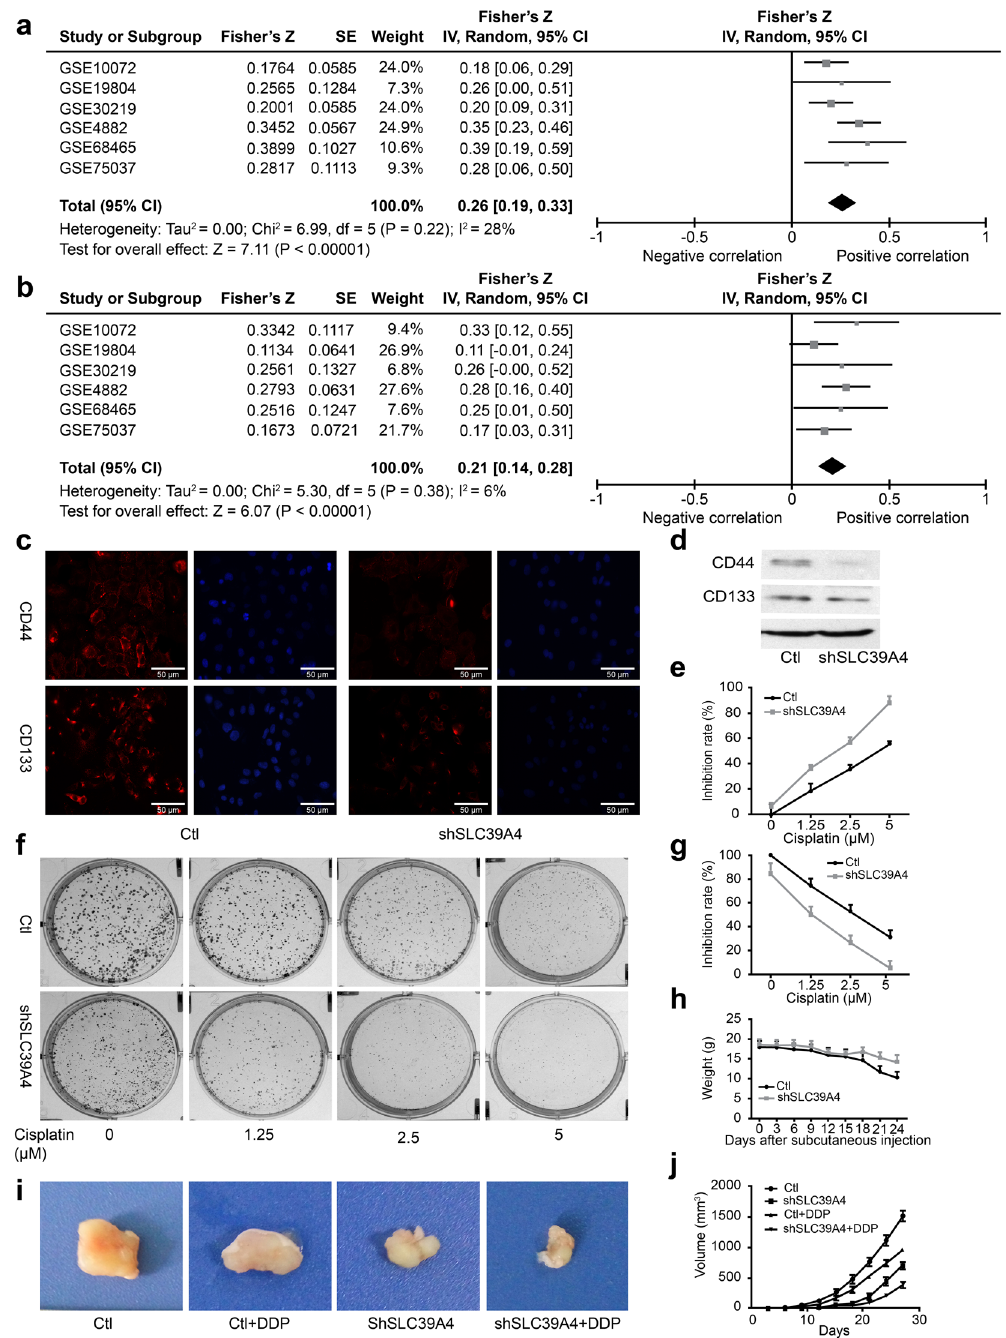
Figure 5. Inhibition of SLC39A4 enhances cisplatin resistance in human NSCLC cells. ( a ) Correlation of SLC39A4 and CD44 expression, Fisher’s Z = 0.26 (95% CI, 0.19–0.33). ( b ) Correlation of SLC39A4 and CD133 expression, Fisher’s Z = 0.21 (95% CI, 0.14–0.28). ( c , d ) Analysis of CD44 and CD133 expression by immunofluorescence ( c ) and western blotting ( d ) in shSLC39A4 or Ctl A549 cells (scale bar, 50 μ m). ( e , f ) Cisplatin-induced cell death was monitored in CCK-8 arrays ( e ) and colony formation assays ( f , g ). Quantitation of colony formation. ( h – j) Body weight ( h ) and tumour size ( i,j ) were used to examine cisplatin sensitivity in shSLC39A4 and Ctl A549 tumour-bearing